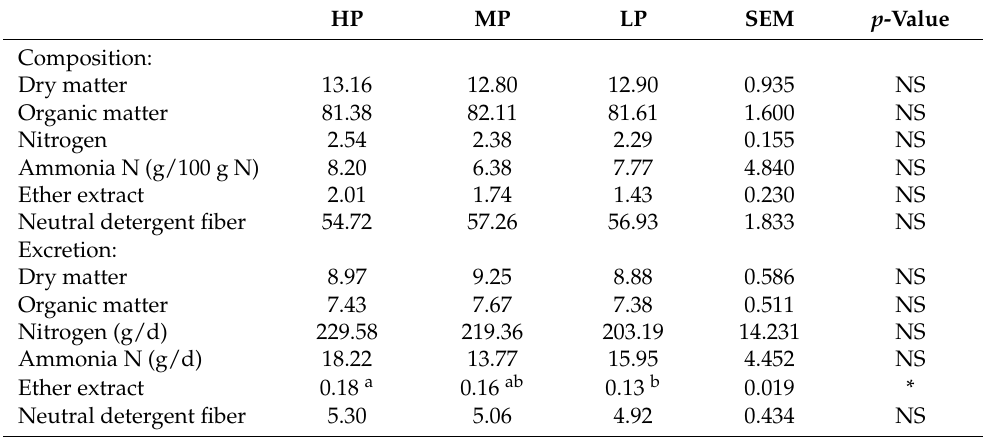
Table 4. Composition of feces (% dry matter basis) and feces excretion (kg/day, dry matter basis) by dairy cows feeding diets with high protein (HP), medium protein (MP), and low protein (LP) levels.